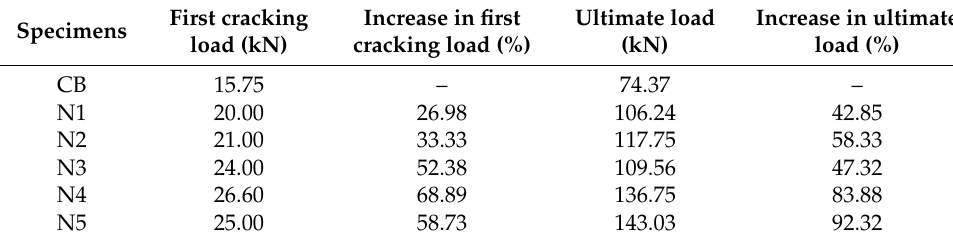
Table 4. Flexural